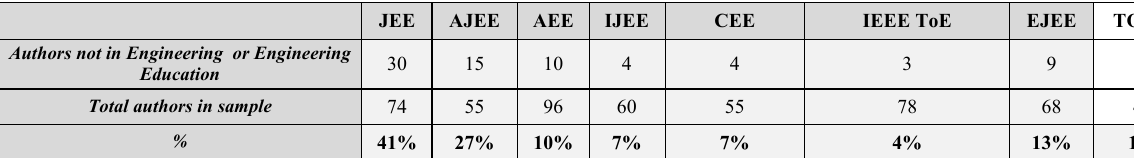
TABLE V. N ON EER- AUTHOR DISCIPLINARY BACKGROUND